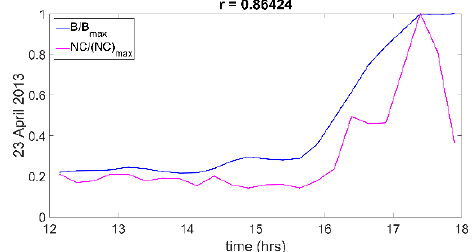
Figure 5. Hourly inter-comparisons of scattering coefficients under low relative humidity (RH < 20%) using the models’ NC/(NC) max and the instrumentation’s results (B/B max ) for 23 April 2013.